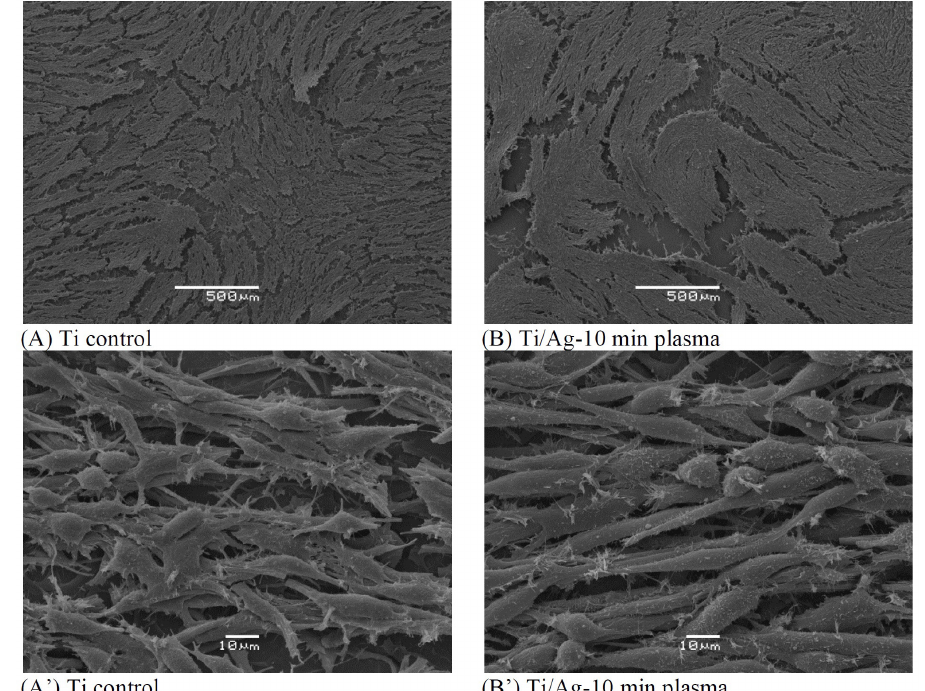
Figure 4. Determination of samples biocompatibility. SEM images of murine fibroblasts adhered to (A and A’) Ti-control and (B and B’) Ti-Ag samples after 7 days grown in routine cell culture